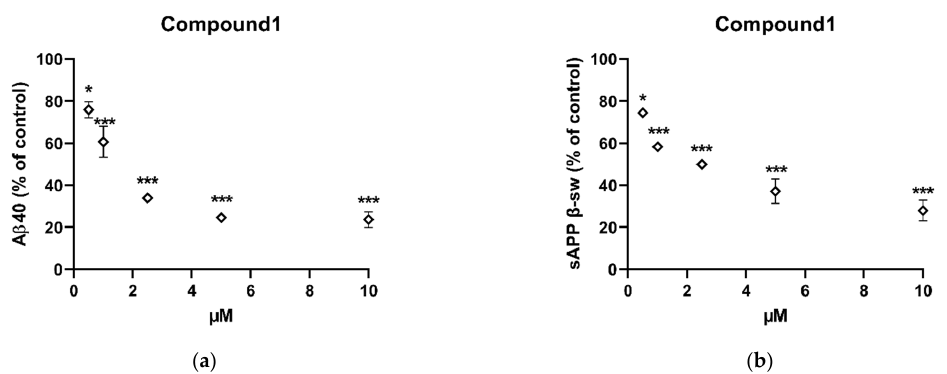
Figure 6. Changes in the level of ( a ) A β 40 and ( b ) sAPP β -sw following exposure to compound 1 in vitro. Cells were incubated with indicated concentrations of the compound for 8 h. The levels of A β 40 and sAPP β -sw were measured from the conditioned media by using ELISA. Statistically significant differences in % of inhibition values are indicated (* p < 0.05 and *** p < 0.001, one-way ANOVA). Data are presented as mean ± SEM ( n = 4). DMSO served as negative control.